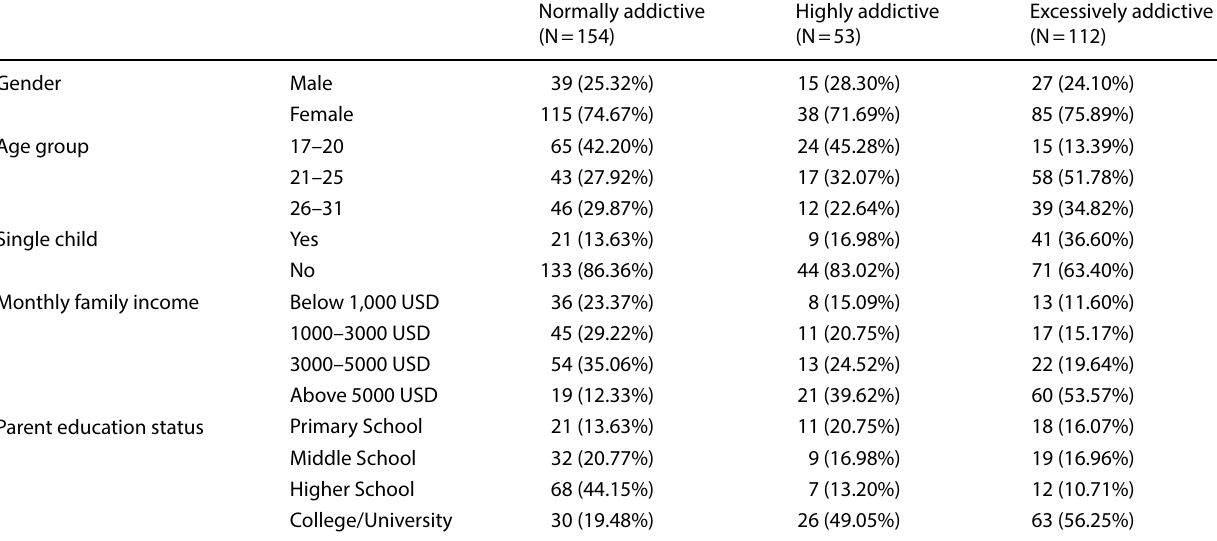
Table 1 Demographic characteristics comparison among normally, highly, and excessively addictive